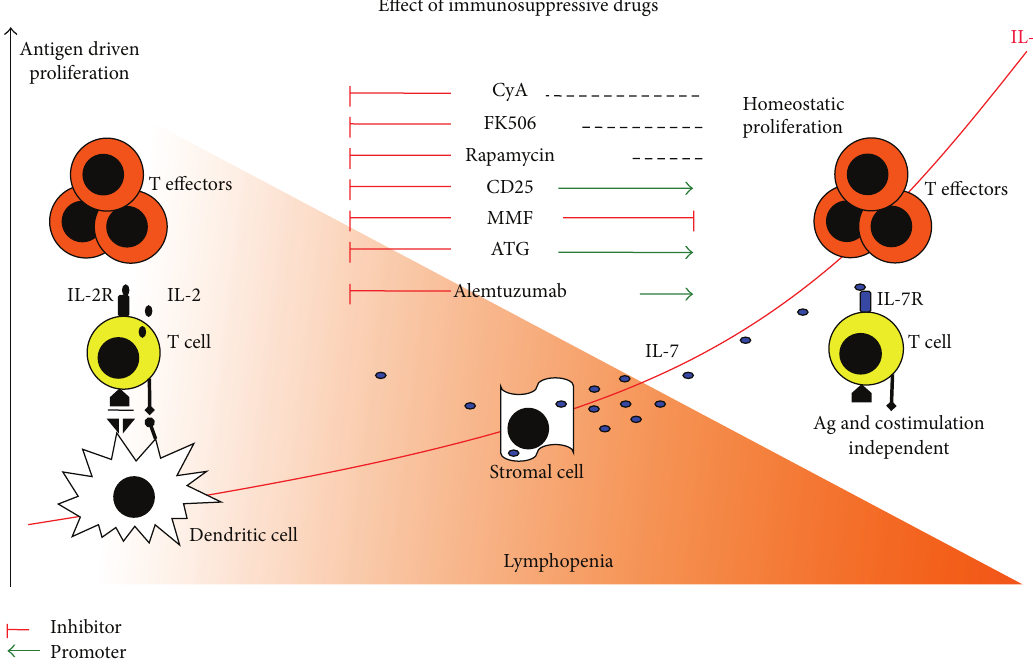
Figure 1: A model comparison of antigen driven versus homeostatic T cell proliferation. In conditions of immune competence and steady- statecirculatinglymphocytecounts,Tcellproliferationcanoccurinanantigen-specificmanner.MHC-peptideantigencomplexisrecognized by a specific T cell receptor on the T cell surface. Antigen-activated T cells express CD25 and produce IL-2 in an autocrine manner. Low levels of IL-7 are necessary for T cell survival. Reduction of T cell number is accompanied by increased IL-7. Proliferation of T cells relies on homeostatic mechanisms. T cells express the IL-7 receptor stimulated by supraphysiological levels of IL-7. Proliferation is antigen and co-stimulation independent and generated effector cells with characteristics that are remarkably similar to those of antigen expanded T cells. All immunosuppressive drugs inhibit antigen-specific T cell proliferation. In contrast, during homeostatic proliferation only MMF can inhibit T cell expansion, whereas cyclosporine A, FK506, and rapamycin have no effect and anti-CD25 monoclonal promotes IL-7 mediated